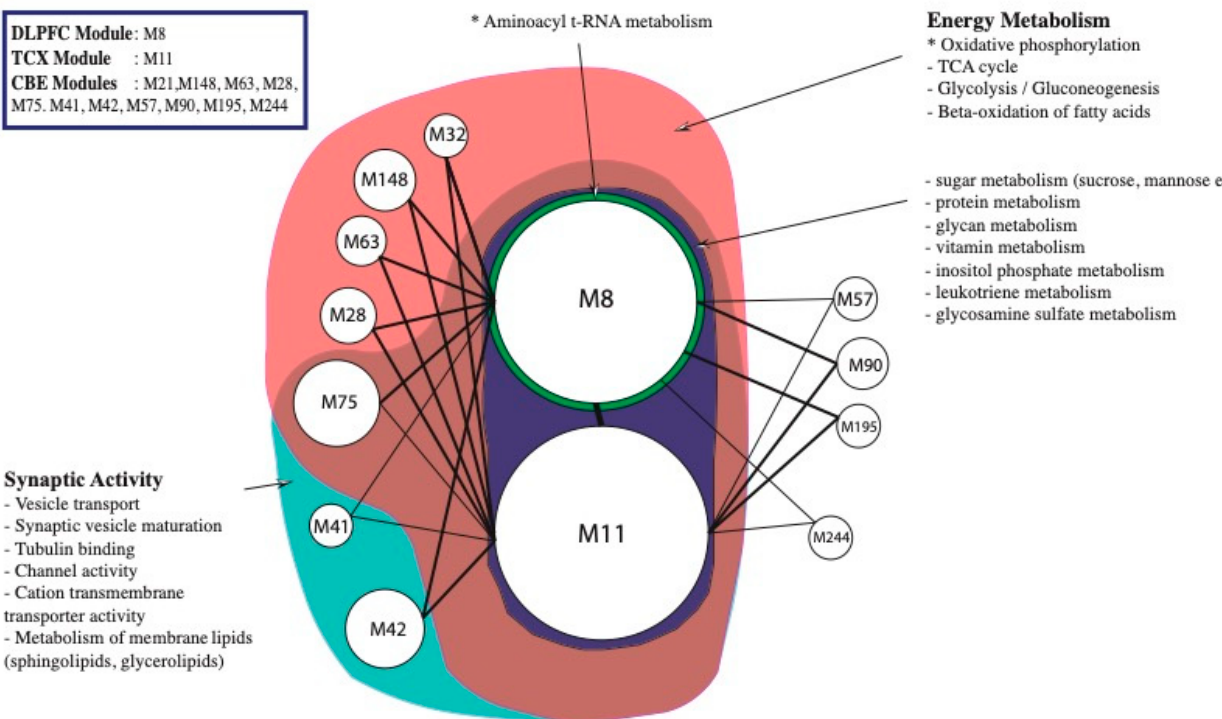
Figure 4. Functional enrichment of significant modules determined from co-expression network by random walk algorithm. M8 (n = 2034), the single module from DLPFC, and M11 (n = 2422), the single module from TCX, were enriched for nearly all metabolic pathways partly due to their size. For instance, genes involved in vitamin, glycan and leukotriene metabolisms were abundant specifically for M8 and M11. Nevertheless, oxidative phosphorylation was the only significant enrichment for both modules (hypergeometric p-value 0.00034 and 0.00054). Aminoacyl t-RNA metabolism was enriched significantly (hypergeometric p-value < 0.0476) for M8 genes. Whereas some CBE modules (M57, M90, M195 and M244) were not enriched for any given annotation, others shared genes associated with synaptic activity and energy metabolism.